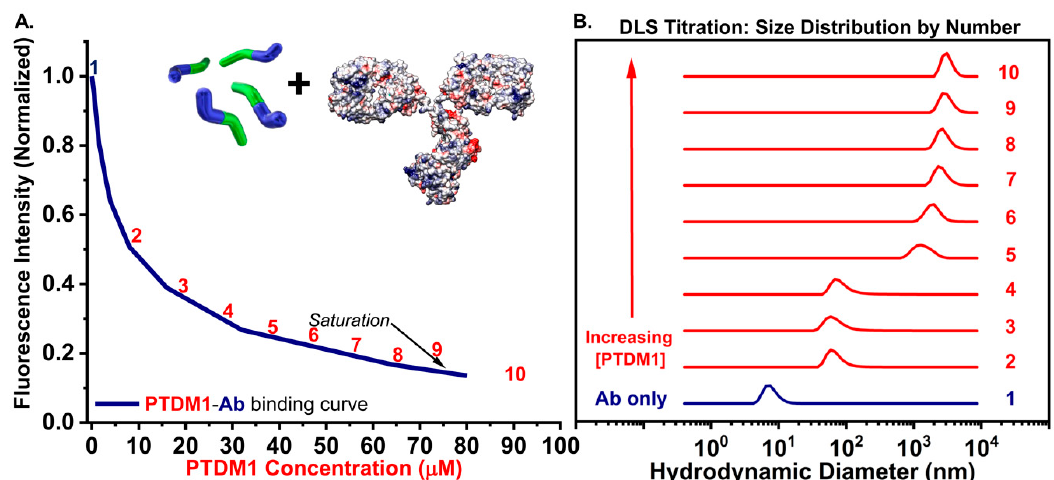
Figure 5. ( A ) Re-plotted Antibody (Ab)-PTDM1 fluorescence-based binding curve from reference 31 with cartoon PTDMs and a model IgG protein shown above (refer to Figure 1 for model information). ( B ) DLS-based titration of Antibody (Ab) with PTDM1 showing protein-induced complex formation at PTDM1 = ~10 µM (step 2) and growth of the complex using increasing PTDM1 concentrations like those used to produce the binding curve in part A.